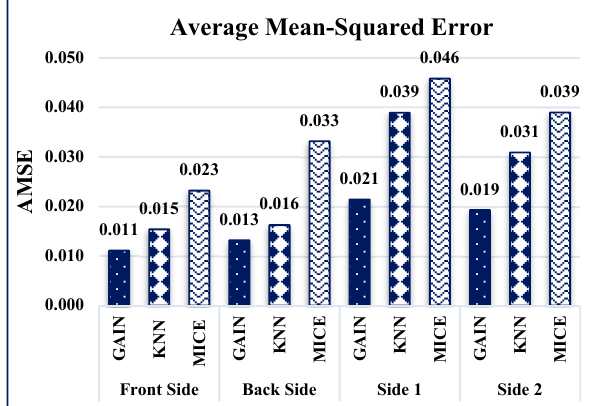
Figure 16. AMSE comparison.